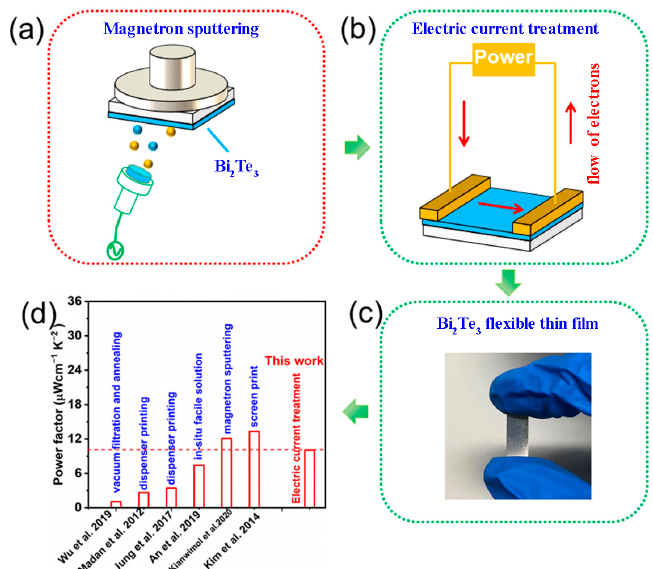
Figure 1. Schematic diagram of: ( a ) magnetron sputtering, ( b ) electric current treatment, ( c ) Bi 2 Te 3 f-TF, ( d ) mechanically alloyed and dispenser printing (2012) [20]; screen print (2014) [32]; disperser printing (2017) [21]; vacuum filtration and annealing (2019) [18]; in situ solution (2019) [33]; magnetron sputtering (2020) [34].